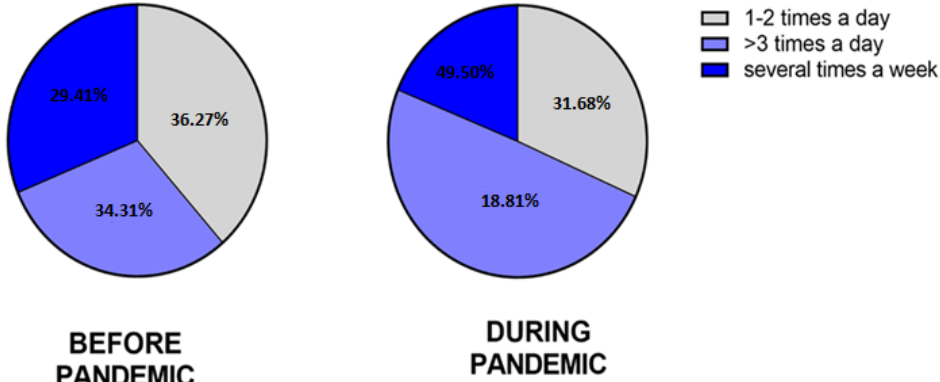
Figure 19. The frequency of moisturizing the skin of the hands in the HE group of respondents before and during the pandemic.